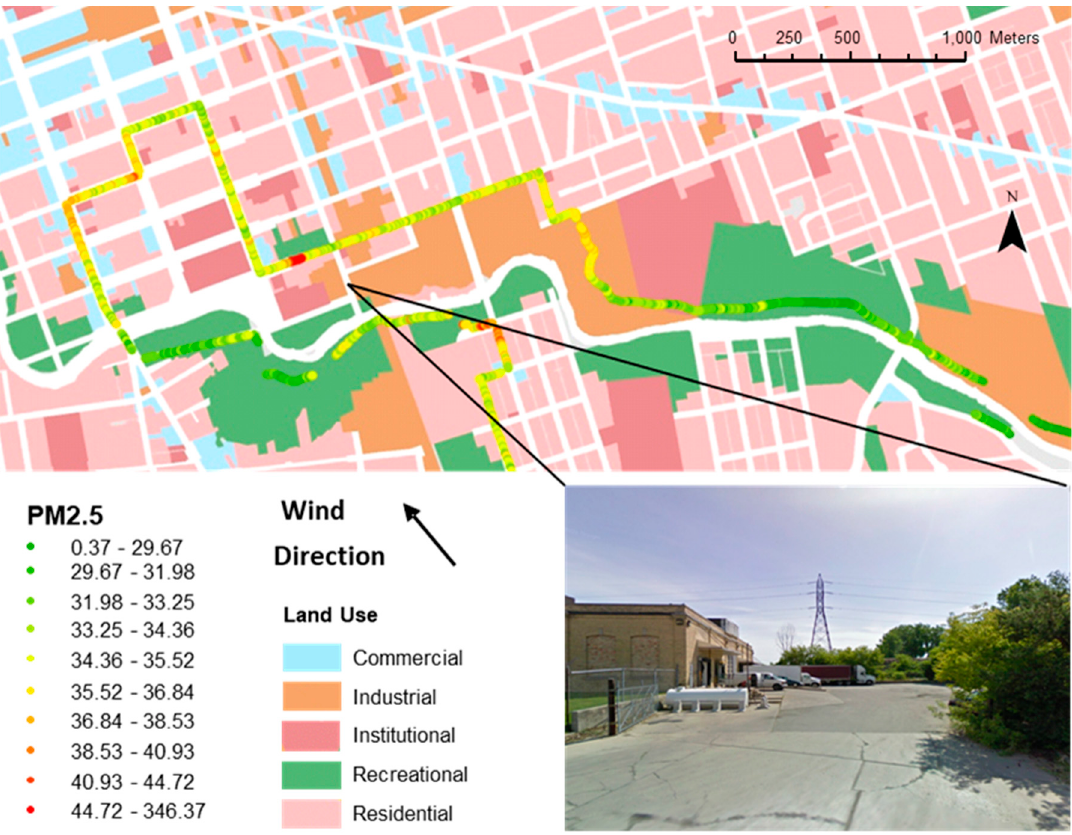
Figure 5. Segment of a single route with 1-s resolution PM 2.5 concentration measurements overlaid on a land use map. Correlation is apparent between personal exposure to PM 2.5 and land use. The loading bay with idling vehicles and wind direction may account for the nearby peak in PM 2.5 . PM 2.5 concentration in µg/m 3 .